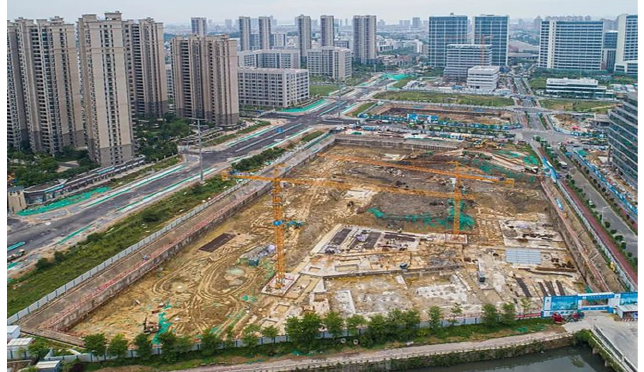
Figure 4. Xiamen Electronic City project under construction.